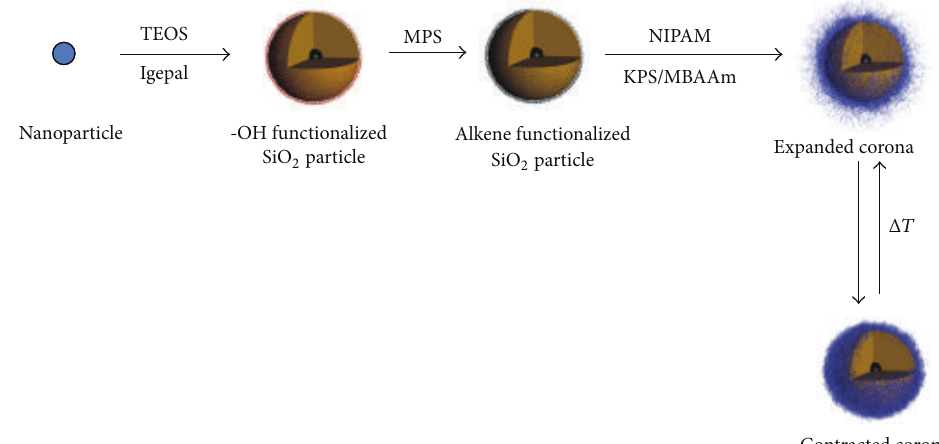
Figure 7: Synthesis of NP/SiO 2 /PNIPAM core-shell-corona hybrid nanogels (reproduced from [86], with permission from Elsevier).